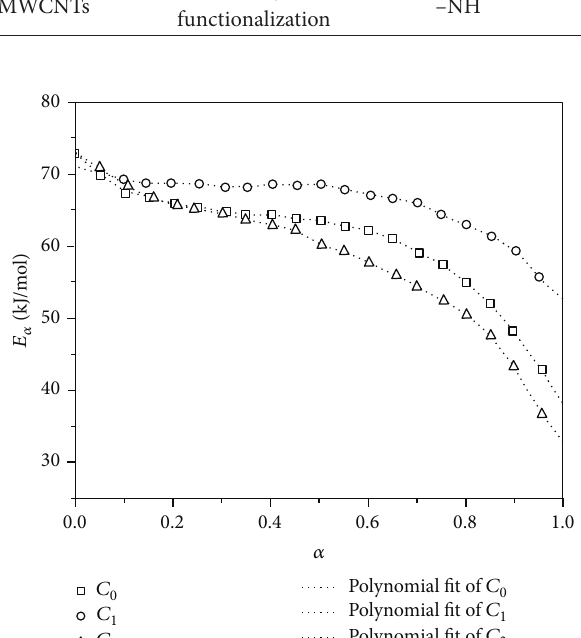
Figure 9: Dynamic DCS thermograms of stoichiometric mixtures ( 𝑟 = 1 ) with different amino-functionalized CNT contents. After